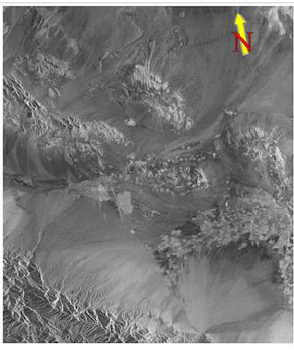
Figure 1. Area under observation sampling range and range time to first pixel are used to calculate flat earth phase of each pixel [4].